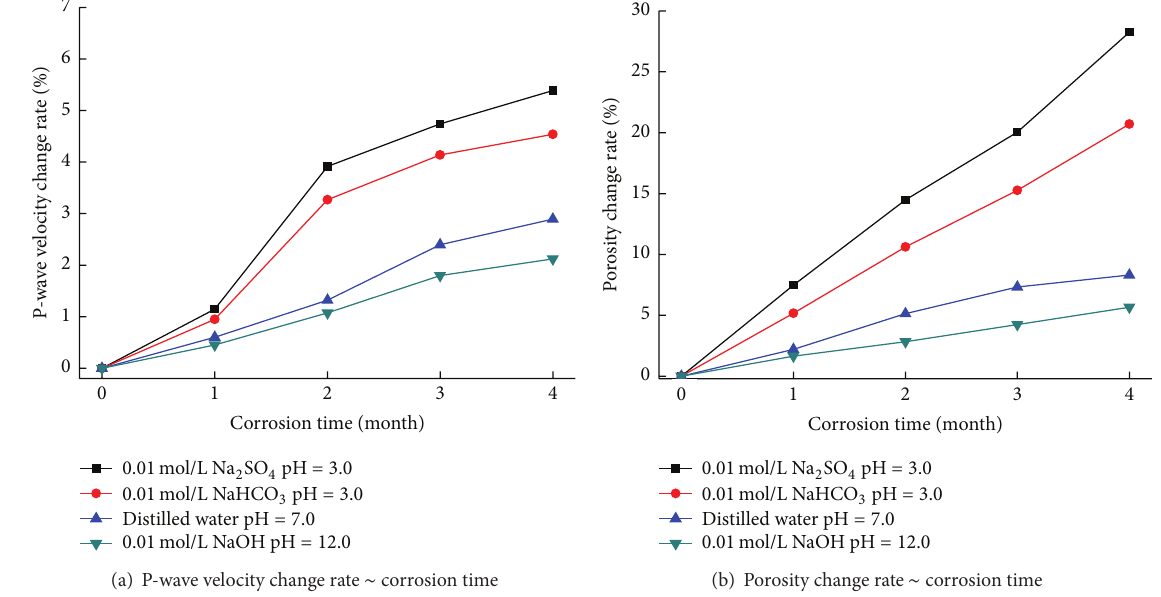
3.03.54.04.55.05.56.0